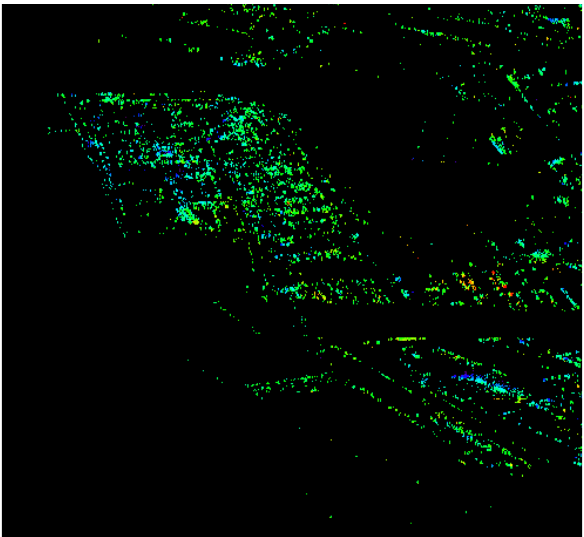
Figure 4. Thermal expansion map from the PSI approach. The colour scale ranges from – 0.5 to + 0.5